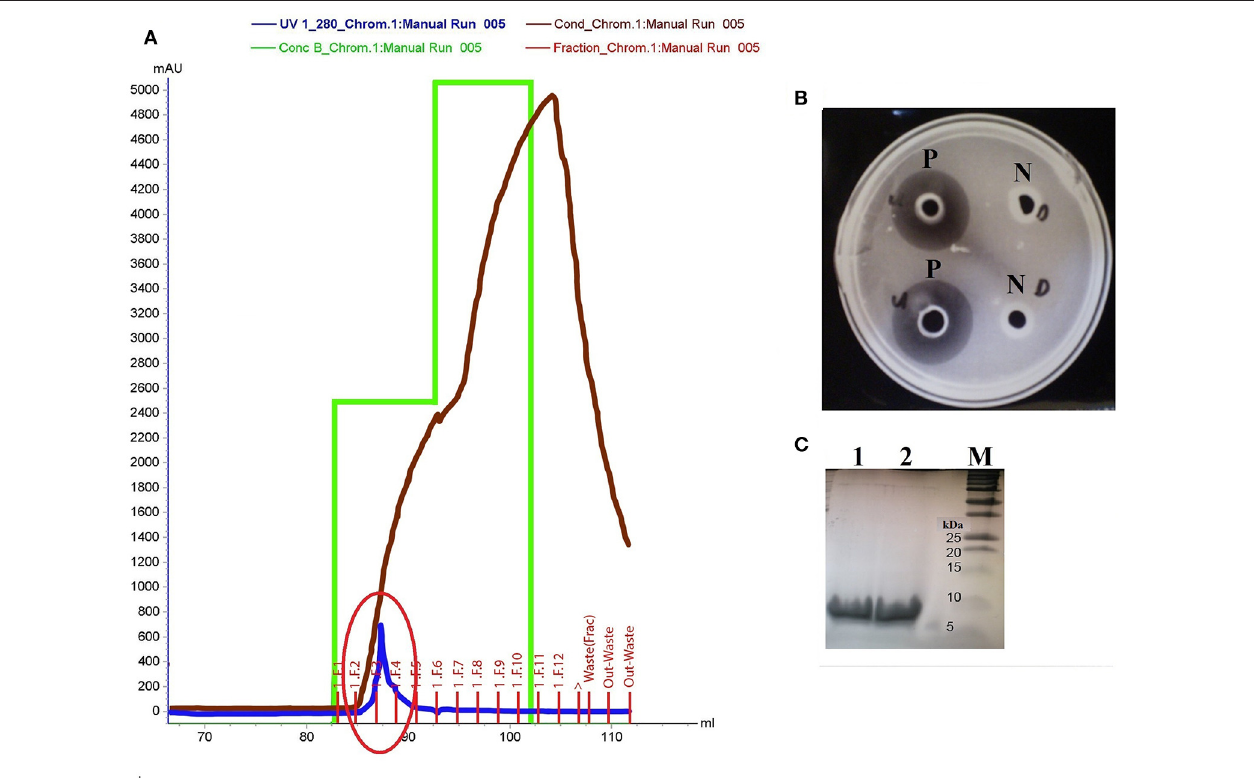
FIGURE 2 | (A) Purification of active fraction using cation exchange chromatography (Hi Trap SP HP cation exchange column) on Akta Purifier System. The purification yields a single peak that covers F2, F3, and F4 fractions (red circle). (B) P: Antilisterial activity assay of the pooled active fractions determined using agar well diffusion method, analyzed in duplicates. N: There was no inhibition zone obtained in the control wells containing Tris-Cl buffer, pH 7.5. (C) SDS-PAGE of the active fraction mixture pooled from F2, F3, and F4 fractions analyzed in duplicates (Lane 1 and 2). Lane M: Precision Plus Protein TM Dual Xtra Standards (BioRad).